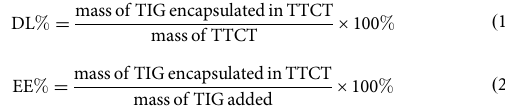
Fig. 2A 56 . Brie fl y, Ts peptide (20 mg) and (Boc) 2 O (11.2 µL) were added to 2mL anhydrous DMSO in an ice bath, followed by stirring at room temperature for 12